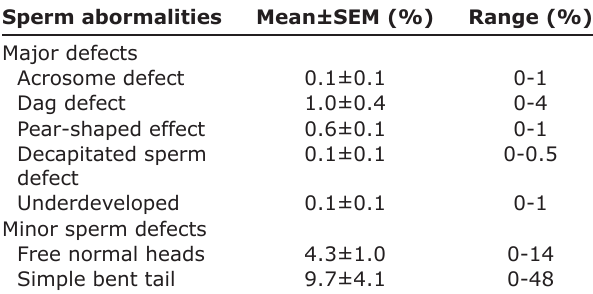
Table-2: Sperm abnormalities mean±SEM (%) of Rusa timorensis .